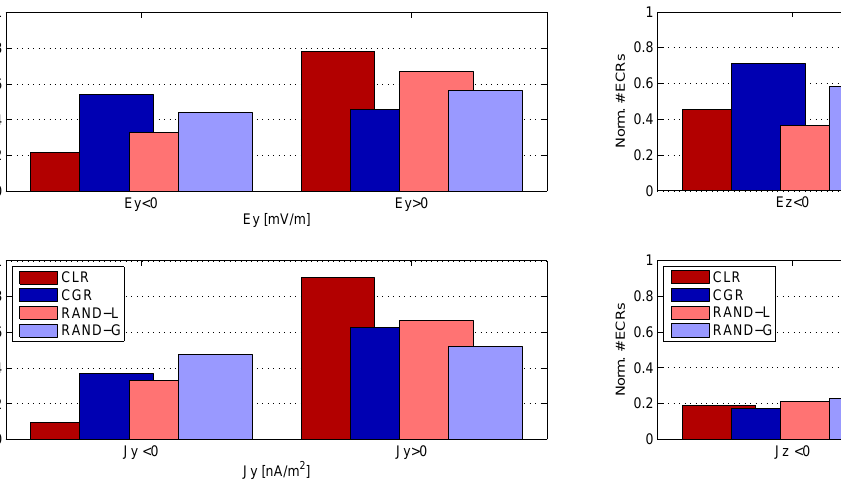
Fig. 10. Histograms of the DSI z electric field and current